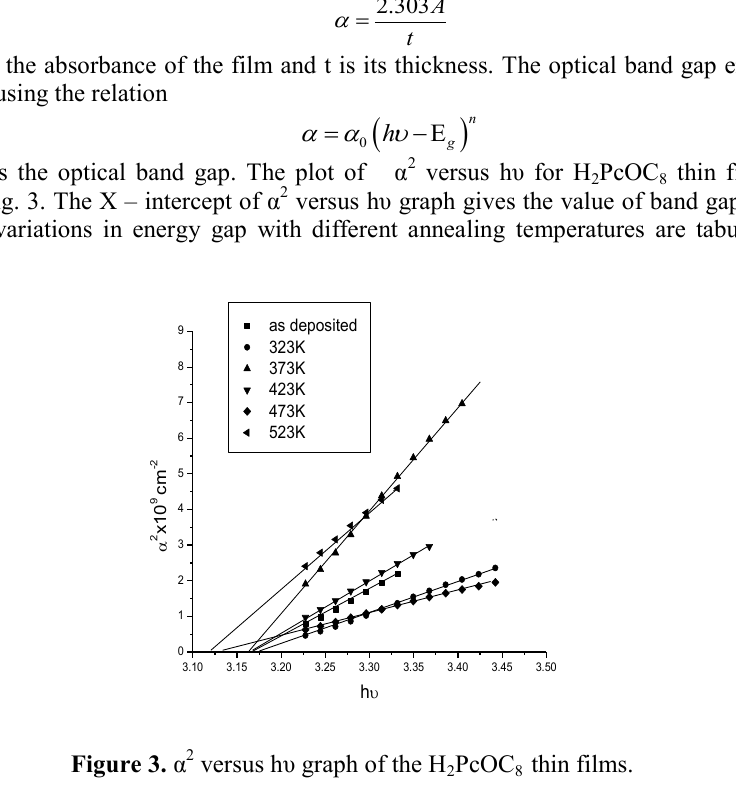
PcOC thin films. 2 8